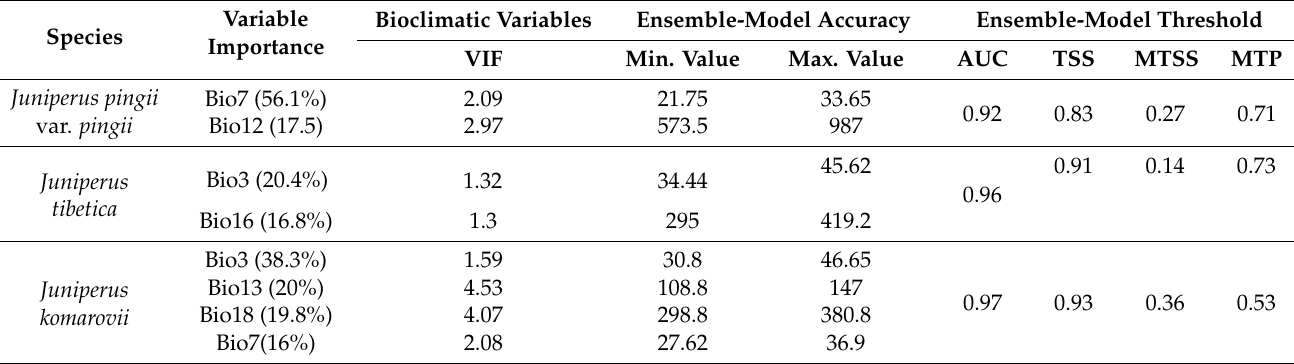
Table 1. The importance of predictor variables in the potential distribution of Juniperus species: correlated variables with variance inflation factor (VIF) values > 5 and a correlation threshold of 0.75 were removed to avoid multicollinearity